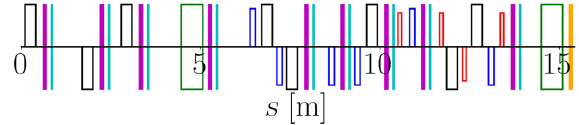
FIG. 8. Schematic showing the locations of BPMs (cyan), a BTV (yellow), and correctors (purple). Magnet positions are shown as outlines. The beam goes from left to right.